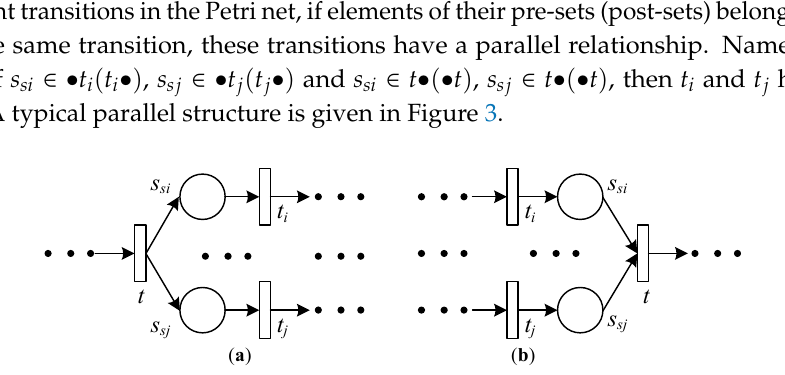
t Figure 4. The competitive structure. In Figure 4, i t and j t are both immediate transitions, and they have a competitive relationship, namely, only one of them can be fired. In maintenance processes, the competitive structure is usually used to express relationships among maintenance tasks after fault diagnosis. Take Figure 4 as an example, the transition t can express the task of fault diagnosis. When there is a token in the state place s s , it means the task of fault diagnosis has been completed, and which unit should be replaced or restored has been decided. Then, transition i t and transition j t will be used to express the replacing or restoring task of unit i and unit j . For all